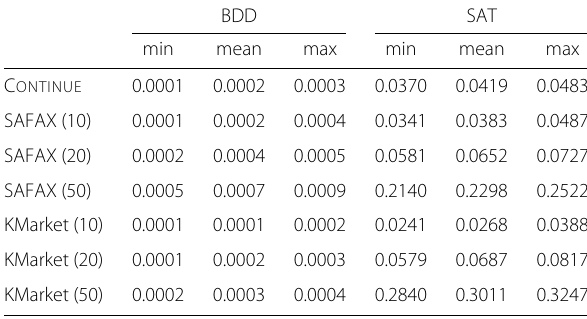
Table 9 Time (in seconds) needed to compute the decision for a concrete query using BDDs and using SAT formulae; the minimal, mean and maximal time are taken from a sample of 100 valid queries BDD SAT